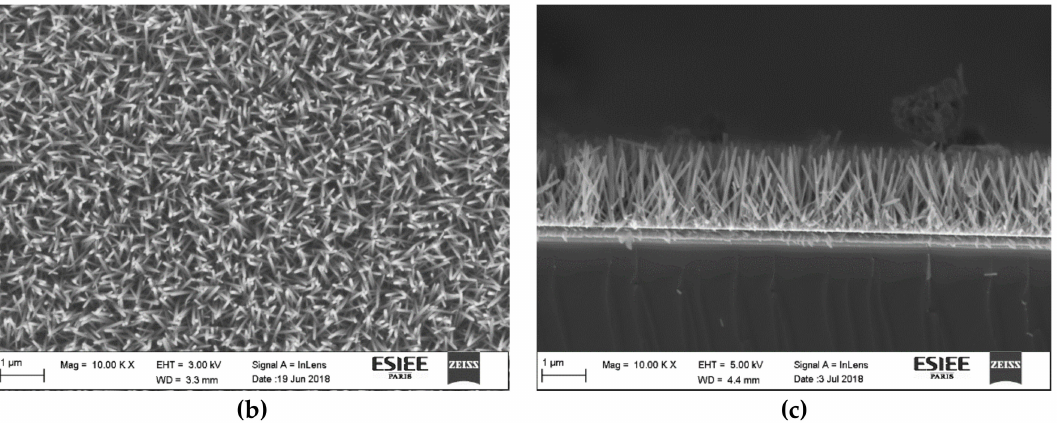
Figure 2. ( a ) Steps of ZnO-NWs synthesis; ( b ) Top view and ( c ) Cross Section SEM images of ZnO-NWs.